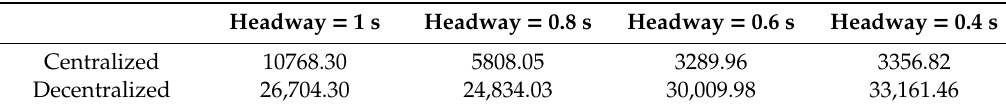
Table 7. Emissions for centralized and decentralized control